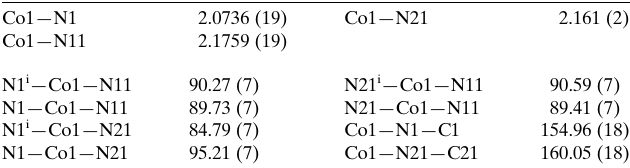
Table 1 Selected geometric parameters (A˚ , (cid:4)